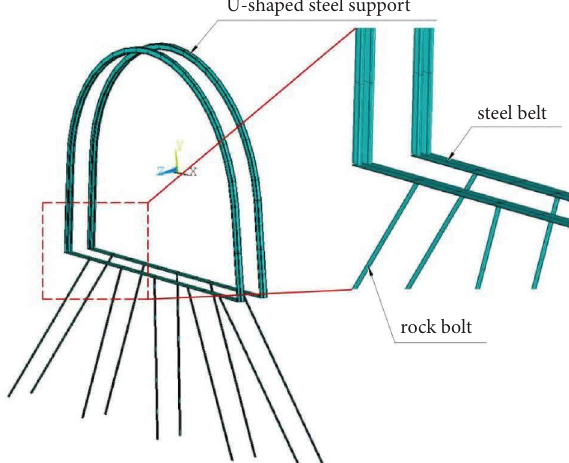
Figure 14: Support elements in the numerical model.